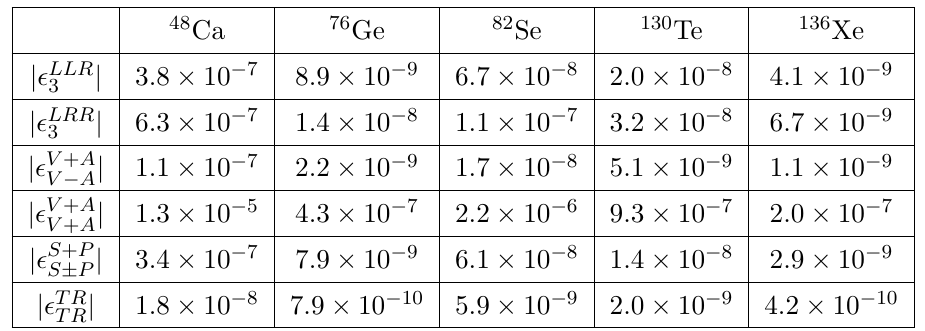
Table 4 . Upper bounds on some j (cid:15) j at the proton mass scale (cid:22) (cid:25) m p derived for various nuclei and assuming one operator is active at a time. Reproduced from ref.